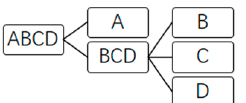
Table 5. The original inflow of the four-component alkane case.